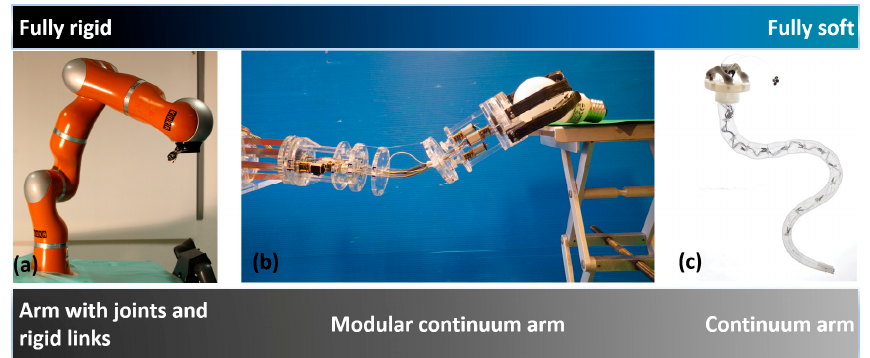
Figure 1. Three examples of arms with different features in terms of materials and stiffness. ( a ) The KUKA arm is a fully rigid structure with joints and rigid links [15]; ( b ) the SIMBA arm is a modular continuum arm with a hybrid structure with rigid and soft materials [16]; ( c ) the soft robot arm inspired by the octopus is a completely soft continuum arm [8,17]. ( c ) Image published under the Creative Commons Attribution (CC BY) license and reproduced from [17].